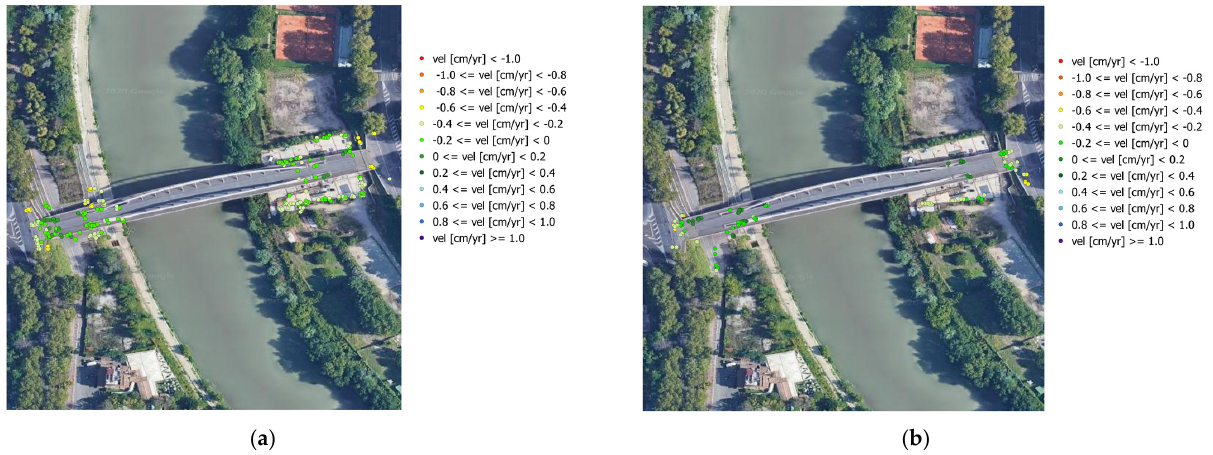
Figure 7. False colors mean deformation velocity maps of the study bridge: ( a ) ascending and ( b ) descending orbits.